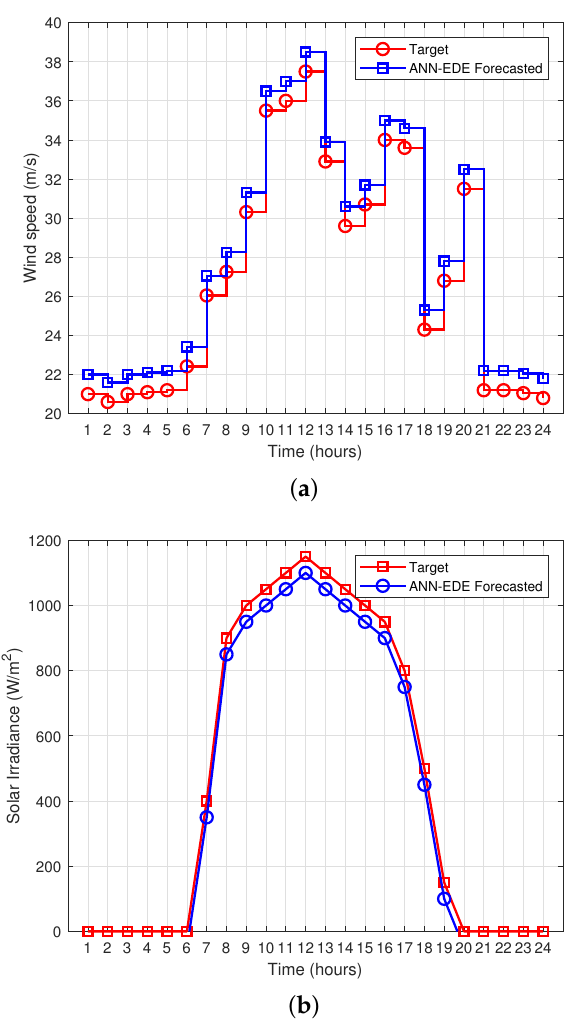
Figure 11. Wind speed and solar irradiance prediction using developed ANN-EDE model for microgrid energy generation estimation. ( a ) Wind speed forecasting. ( b ) Solar irradiance